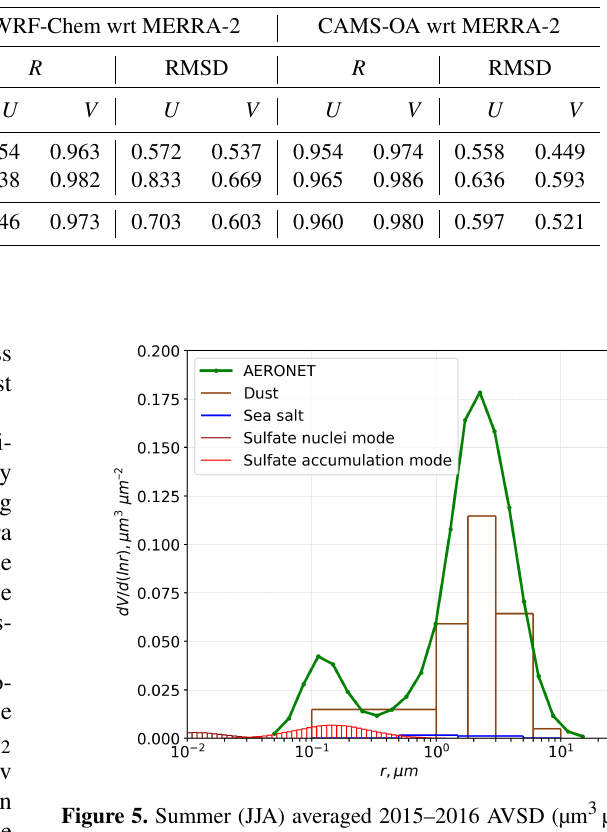
Table 3. Pearson correlation coefficient R and root mean square difference (RMSD; ms − 1 ) for the seasonally averaged 2015–2016 wind components U and V at 10m.